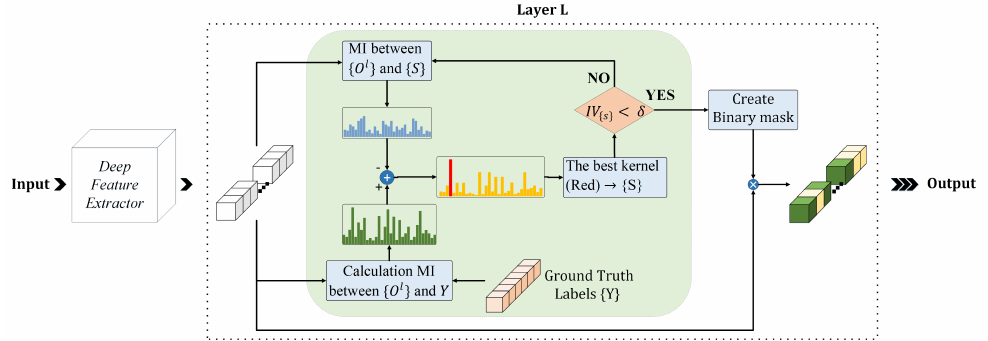
Figure 1. Applying MI dropout to the l th dense hidden